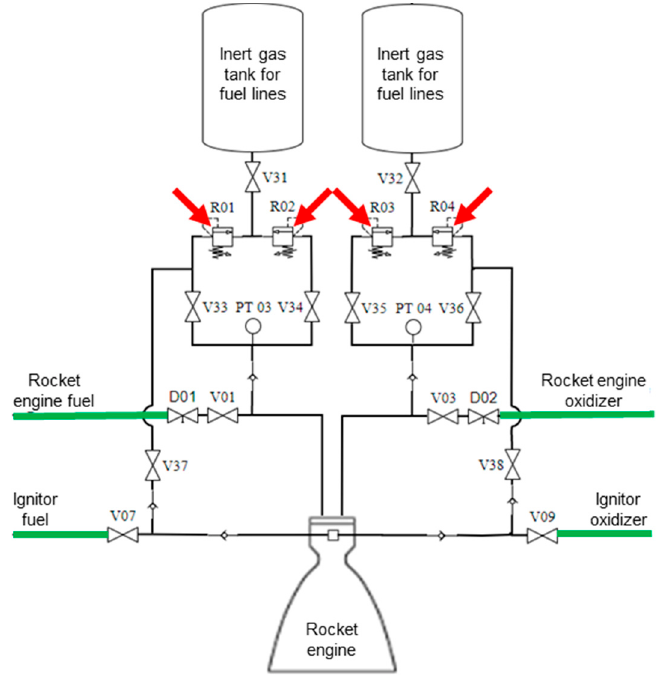
Figure 39. Algorithm’s 15th step diagram.